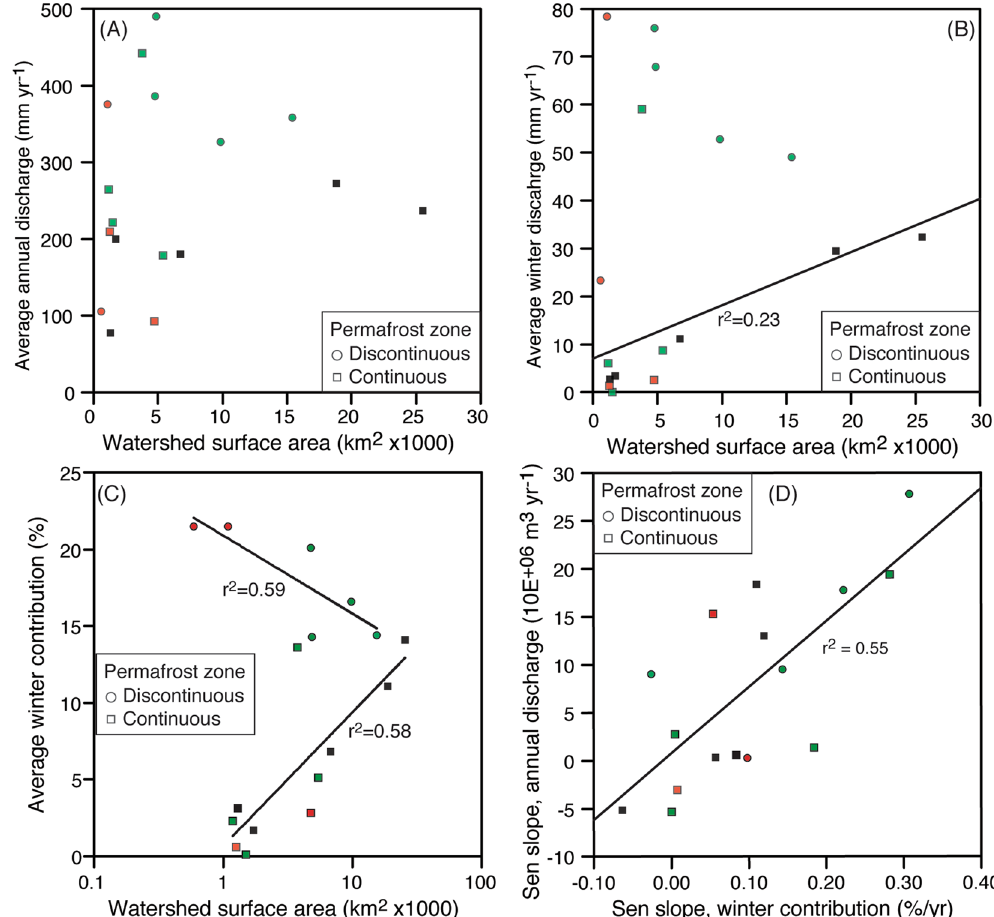
Figure 4. Hydrometric data of gauging stations in northwestern Canada separated by permafrost zone. (see Table 1 for list of stations). ( A ) Relation between annual discharge and watershed area in continuous and discontinuous permafrost. ( B ) Relation between winter discharge and drainage area in continuous and discontinuous permafrost. ( C ) Relation between winter discharge contribution to total annual discharge and drainage area in continuous and discontinuous permafrost. ( D ) Relation of Sen slope trend between total annual discharge and winter contribution. Note: Red symbol = no icings in the watershed; Green symbol = icings along the river with a gauging station; Black symbol = icings in the watershed but not along the river on which the gauging station is found. Linear trend lines are shown for statistically significant relations ( P <